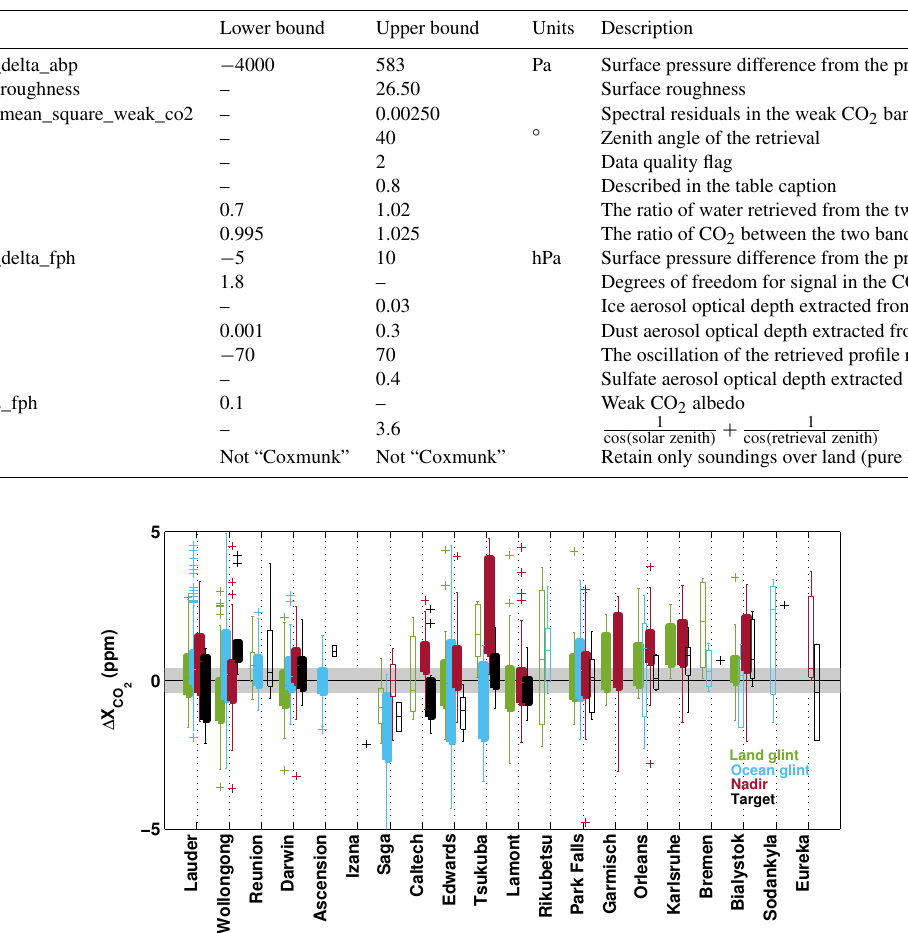
Table 2. Filters applied to the target-mode OCO-2 data from the standard OCO-2 files (i.e., not the “lite” files). The parameter names listed below are written as they are in the standard L2 files. Parameters for which there is only one limit are marked with a “–”. The units are listed where applicable. The parameter “blended_albedo” is defined as 2.4 × albedo_o2_fph − 1.13 × albedo_strong_co2_fph. The tag “fph” denotes parameters from the full physics algorithm; “abp” denotes parameters from the A-band preprocessor algorithm designed for quick cloud screening; “idp” denotes the IMAP-DOAS preprocessor.